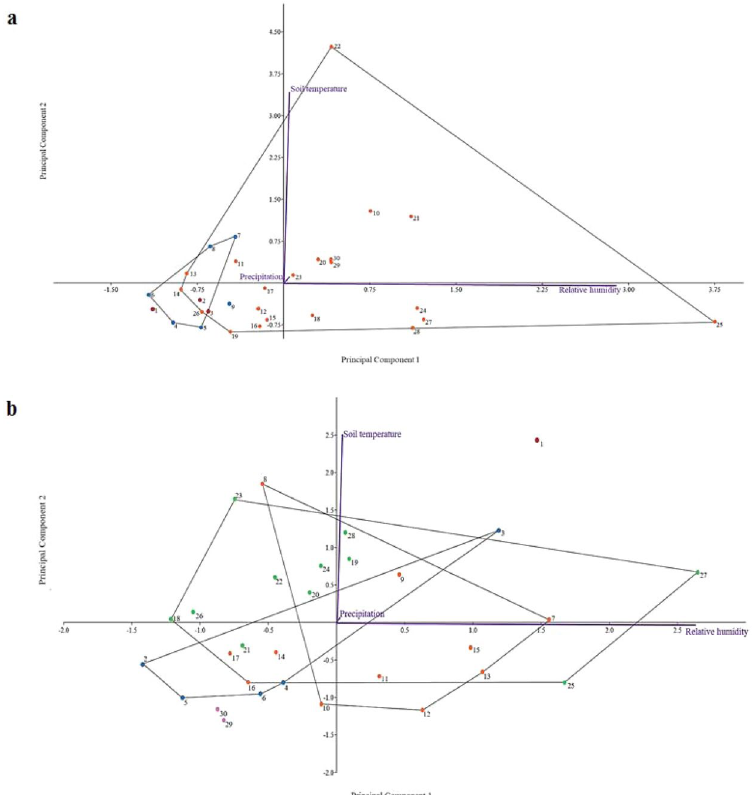
Figure 3. PCA of the environmental factors on the buried rat carcasses decomposition process during ( a ) March, and ( b ) June. 1–30 represent post burial days interval: fresh (red); partially bloated and bloated (blue); active and advanced decomposition (orange); advanced decomposition (green); skeletal remains